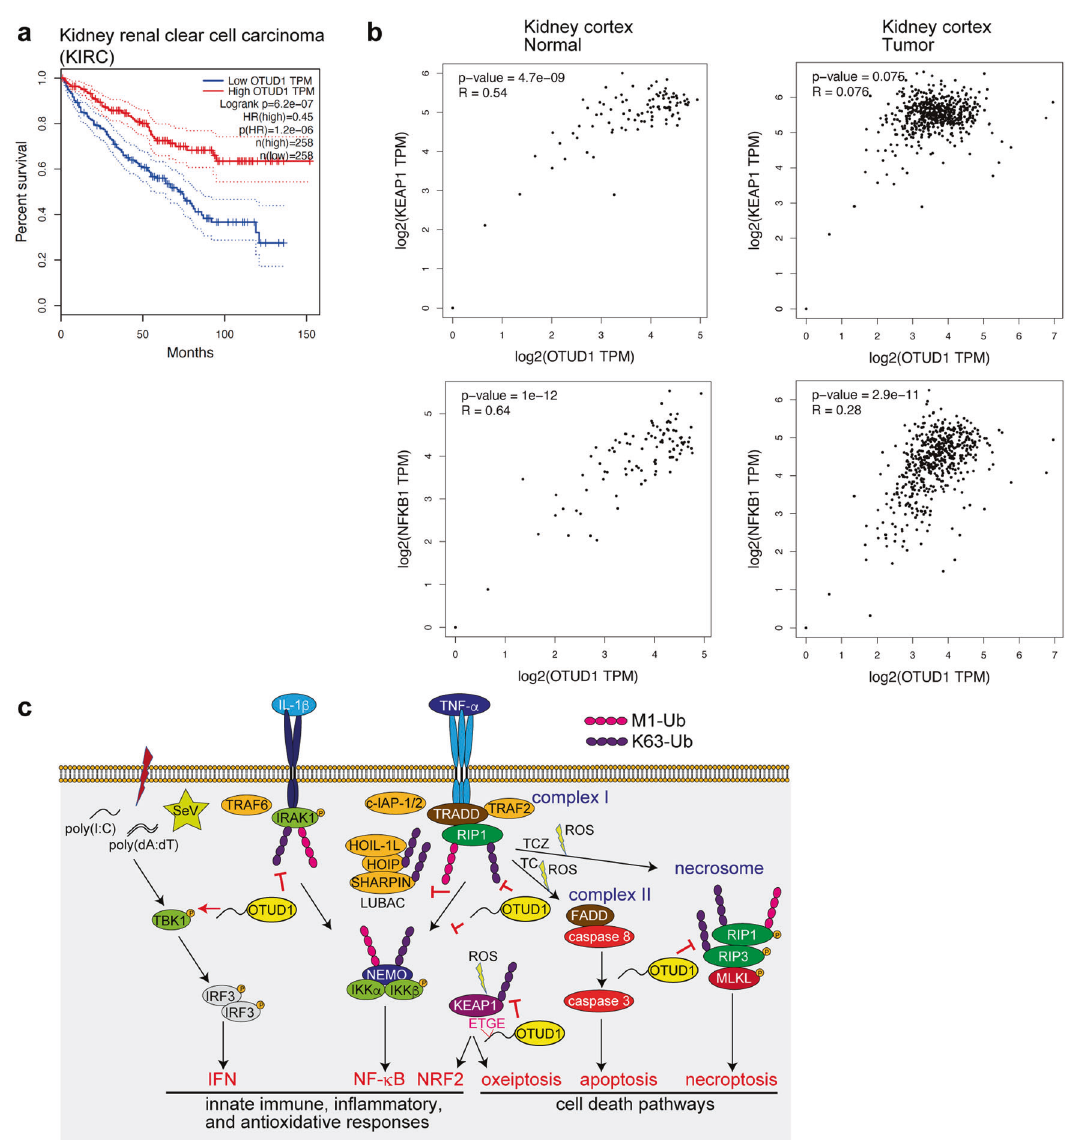
Fig. 7 OTUD1 suppresses kidney cancer. a Low expression of OTUD1 is a poor prognosis factor in kidney cancer. Kaplan – Meier survival curves of patients with kidney renal clear cell carcinoma (KIRC) with high ( n = 258 patients) and low ( n = 258 patients) expression of OTUD1 mRNA, determined by the Log-rank test, are shown. b Loss of positive correlation between OTUD1 and KEAP1 in kidney cancer. Correlations of expression levels with Pearson correlations and P -values of OTUD1 vs . KEAP1 ( upper panels ) or OTUD1 vs . NF- κ B1 ( lower panels ) in normal ( left panels ) and tumor ( right panels ) kidney cortex are shown. c Schematic representation of OTUD1 functions in the regulation of in fl ammatory and KEAP1-mediated oxidative stress responses, and cell death pathways. Cell Death and Disease (2022)